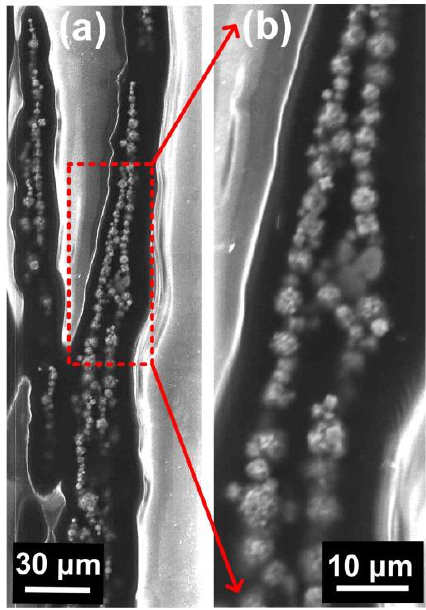
Figure 1. Illustration of preparation setup for vertical protrusive Shape Memory Polymer/Nickel (SMP/Ni) chains. ( a ) Random distribution of SMP/Ni solution without applying magnetic field; ( b ) Setup for preparing SMP/Ni vertical chain arrays; ( c ) Formation of SMP/Ni vertical chain arrays with applying magnetic field .